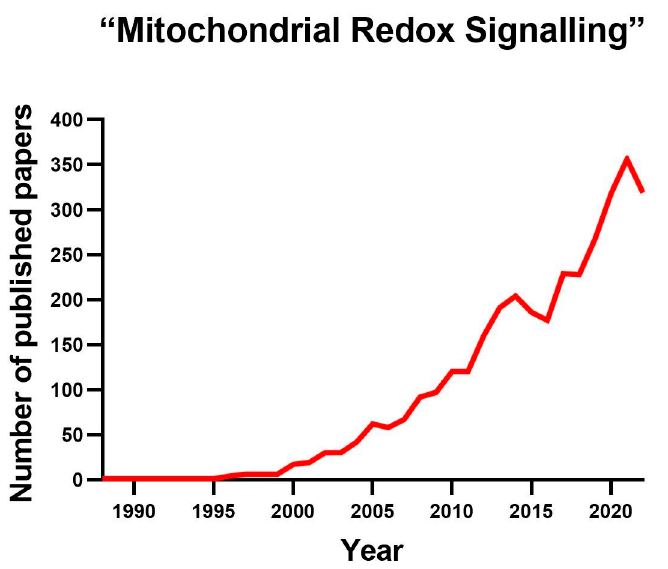
Figure 1. Number of published papers containing the expression “Mitochondrial Redox Signalling” in their titles or abstracts, as extracted from the Scopus database. The y-axis indicates the number of publications per year, and the x-axis shows the years included in the search. The data provide insights into the growing popularity of redox biology within the scientific community.